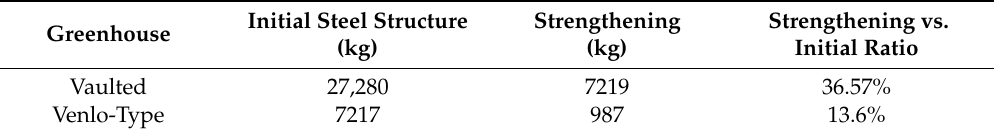
Table 11. Weight of steel for initial structure and